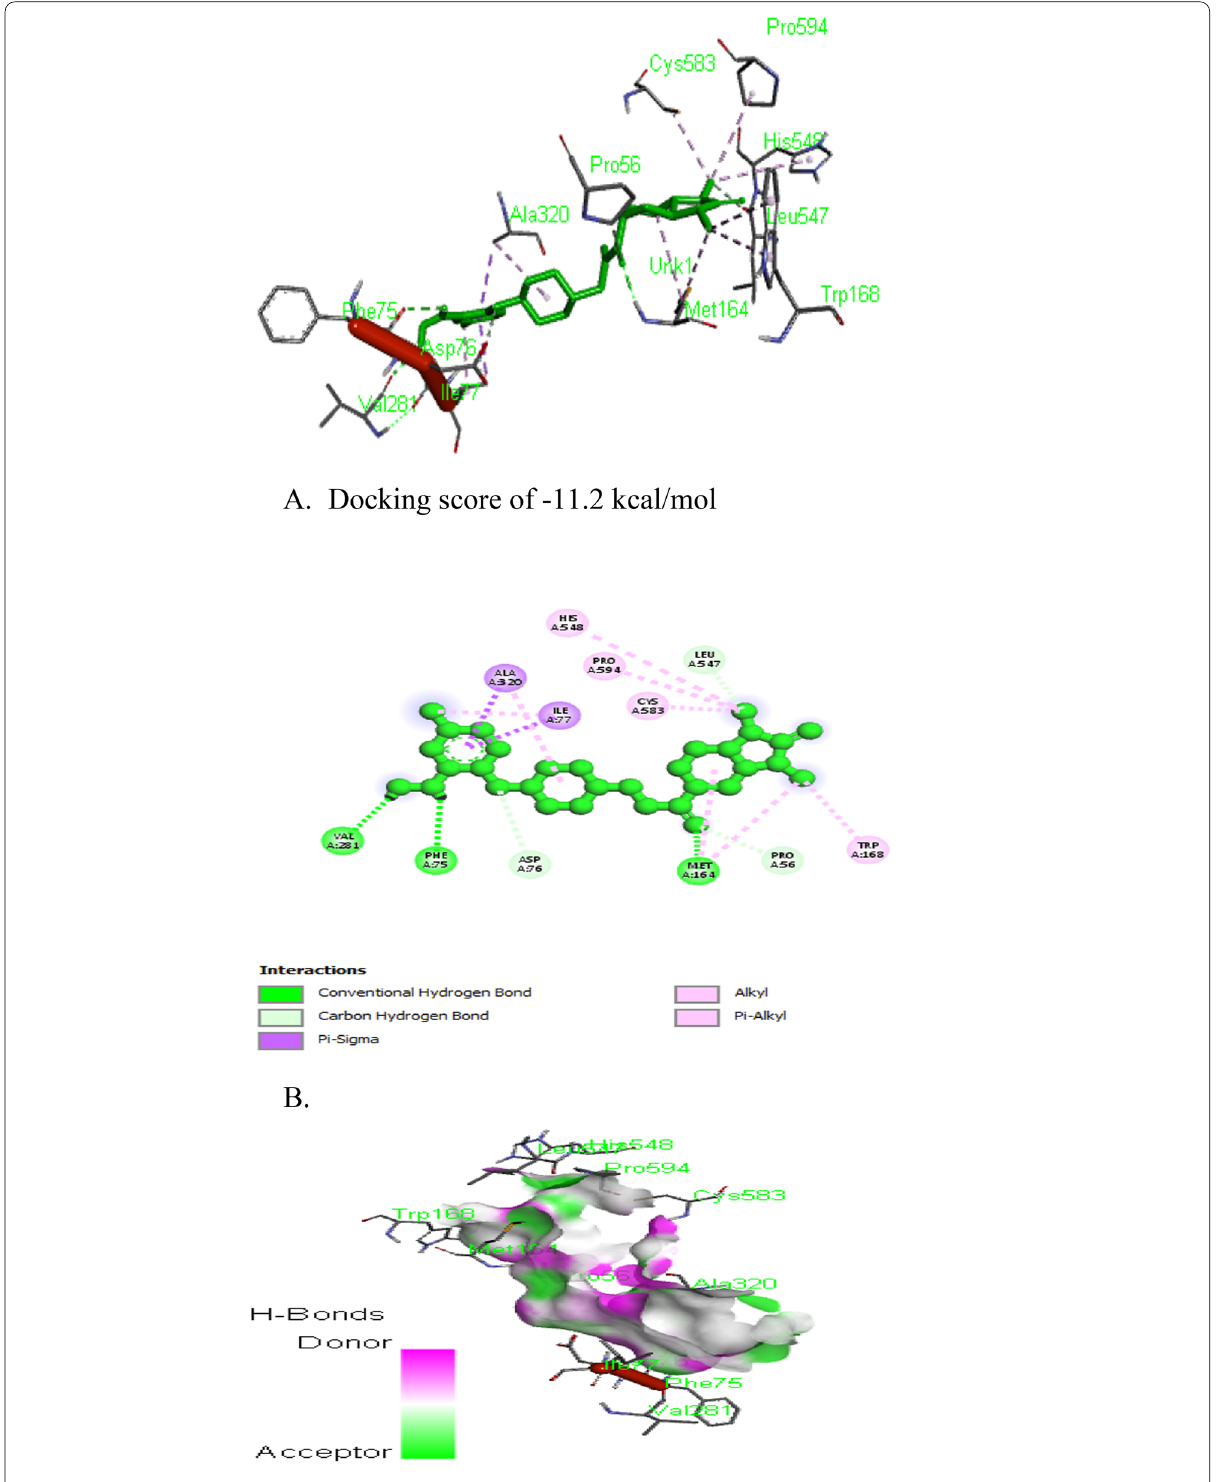
Fig. 5 A and B show the 3D and 2D docking interactions between ligand 13 and receptor,